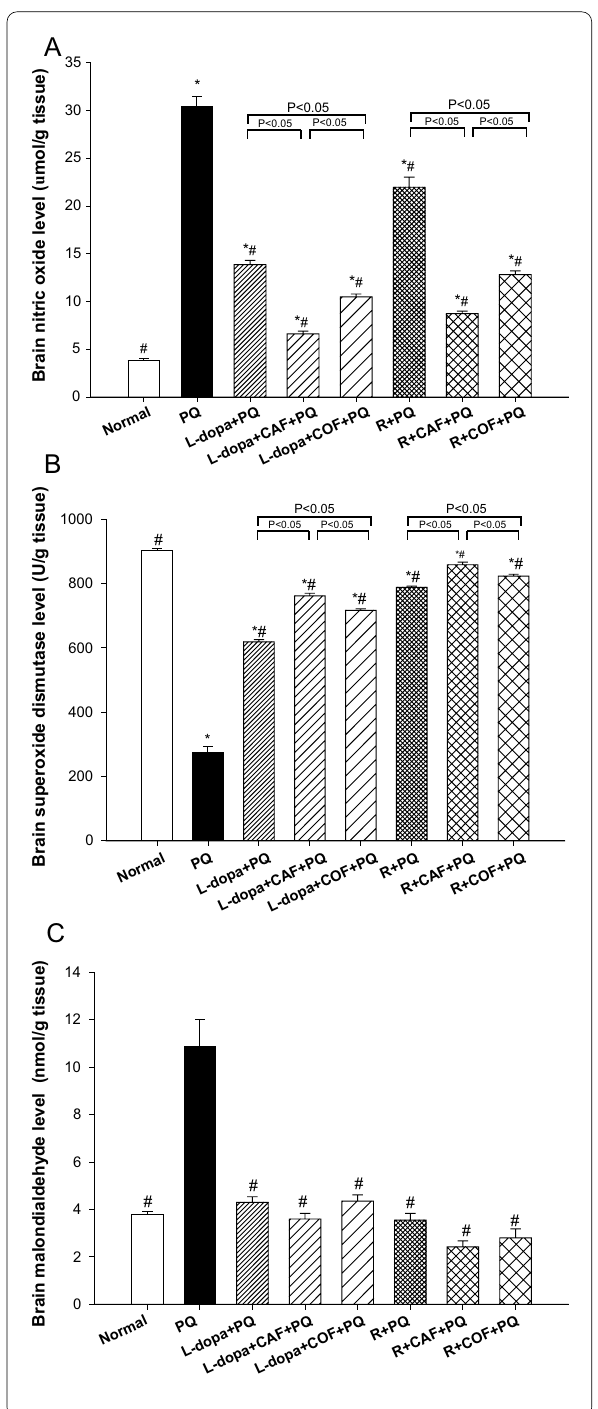
group with significant increase (P < 0.001) in GFAP ve + cesses (Table 2; Fig. 11B) reaching 123.26% compared to normal mice. GFAP ve astrocytes showed signifi- +